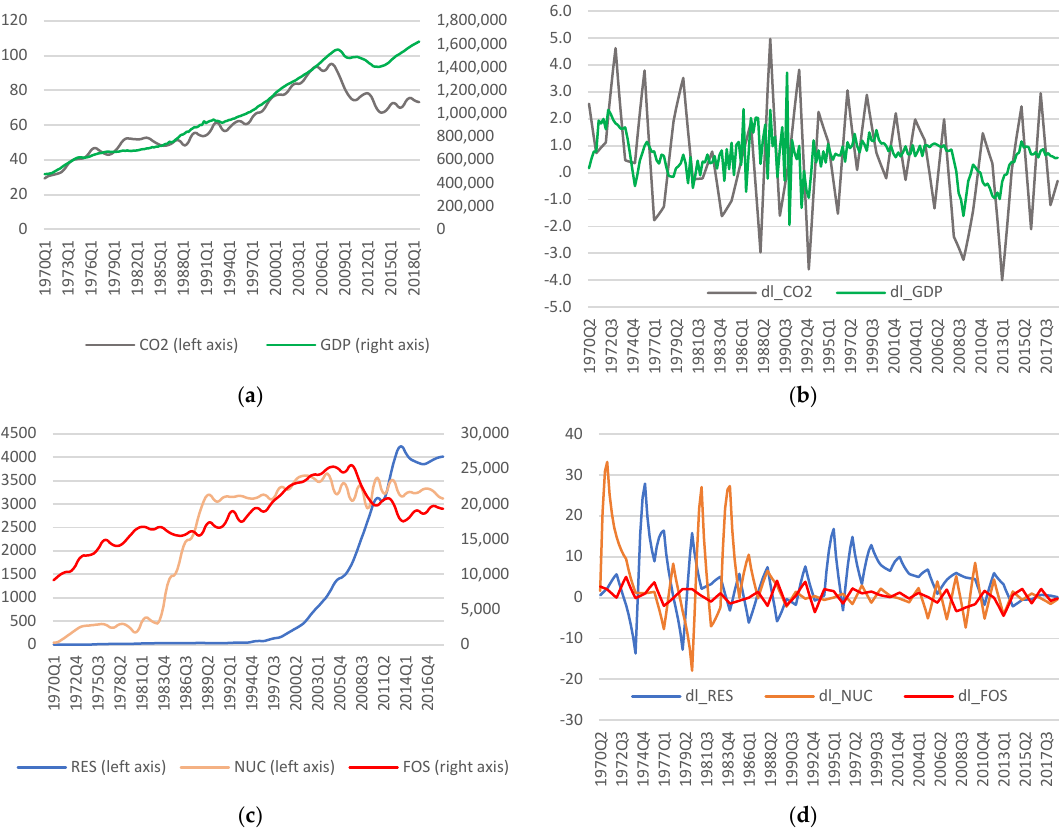
Figure 1. CO 2 emissions, GDP, nuclear and renewable energy and fossil fuel consumption in Spain over the period of 1970Q1–2018Q4. ( a ) CO 2 emissions (in millions of tons) and GDP (in 2010 U.S. dollars); ( b ) growth rates of CO 2 emissions and GDP; ( c ) renewable and nuclear energy and fossil fuel consumption (in thousand toe); and ( d ) growth rates of renewables, nuclear energy and fossil fuel consumption. Note: Fossil fuel (coal and oil) consumption (FOS, in thousand toe) was calculated using data retrieved from the BP Energy Outlook 2019 database.